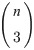
Divergence of estimated gene tree (triplet) distributions from true gene tree distributions for MP-EST analyses of simulated avian datasets.In (a), we vary the gene sequence length (250bp genes have the highest error, and 1500bp has the lowest error) and explore 1000 genes under default ILS levels, and in (b) we vary the amount of ILS and fix the number of genes to 1000 and sequence length to 500bp. True triplet frequencies are estimated based on true gene trees for each of the (n3) possible triplets, where n is the number of species. Similarly, triplet frequencies are calculated from estimated gene/supergene trees. For each of these (n3) triplets, we calculate the Jensen-Shannon divergence of the estimated triplet distribution from the true gene tree triplet distribution. We show the empirical cumulative distribution of these divergence scores. The empirical cumulative distribution shows the percentage of the triplets that are diverged from the true triplet distribution at or below the specified divergence level. Results are shown for 10 replicates. We used 50% bootstrap support threshold for binning, and estimated the supergene trees using RAxML with unpartitioned analyses.